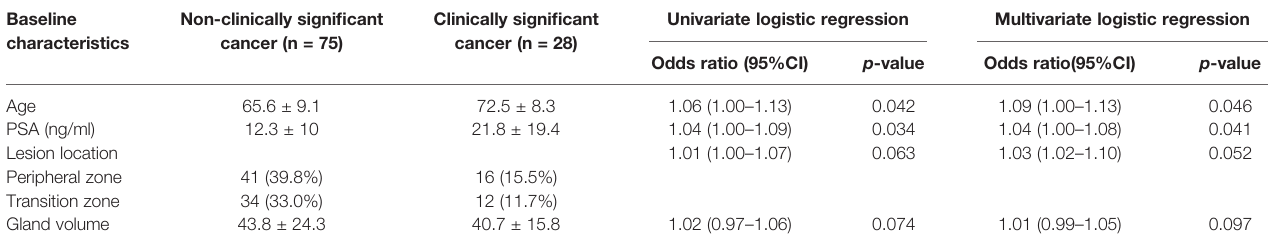
TABLE 3 | Univariate and multivariate logistic analyses results of clinical factors.